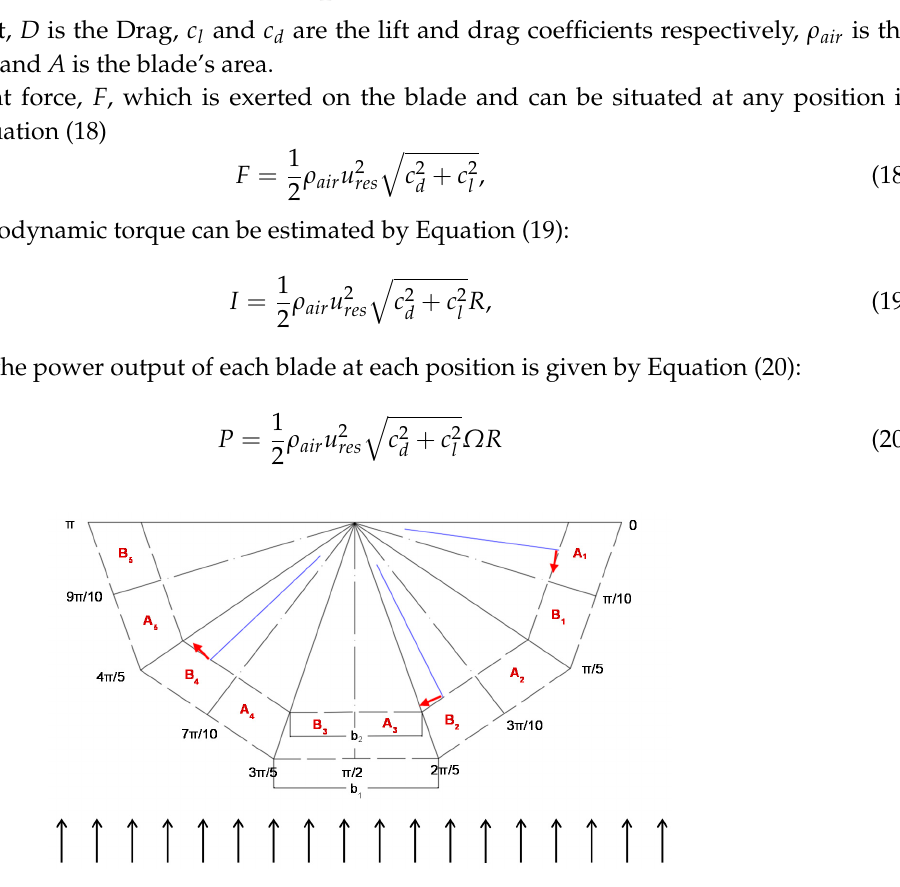
Figure 2. Analysis of the half top view of the stator, in order to calculate the magnitude of velocity inlet and the resultant velocity at various stator sections.